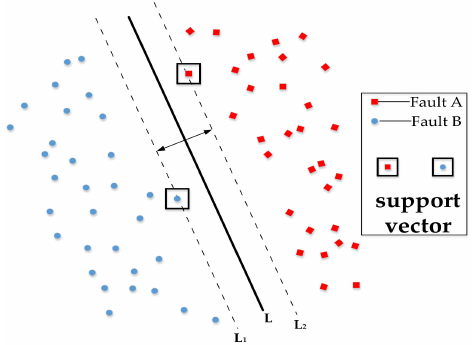
Figure 6. Optimal classification